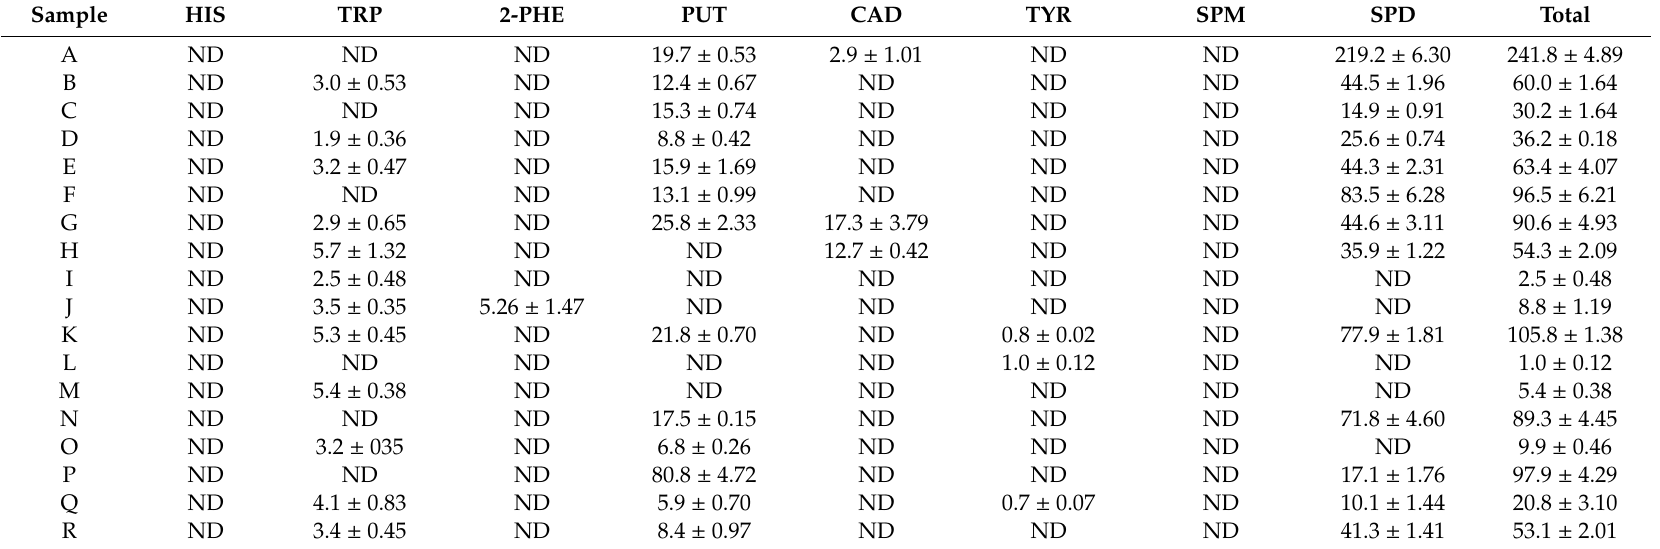
Table 2. Biogenic amines content (mg / L) in 18 home-made maesil extracts prepared in individual households.